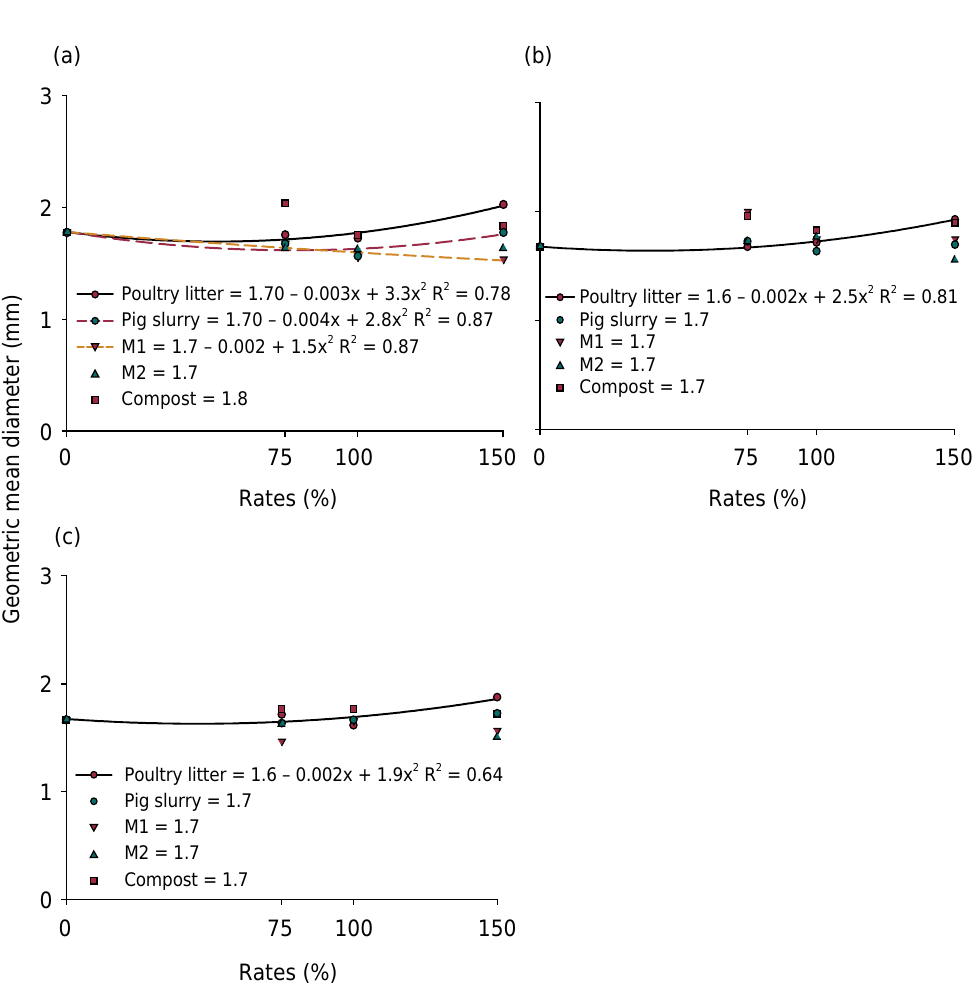
Figure 2. Geometric mean diameter (mm) of aggregates from a Rhodic Kandiudox, in the layers after seven years of different types and rates of organic and mineral fertilizers application. (a) 0.00-0.05 m soil layer; (b) 0.05-0.10 m soil layer; and (c) 0.10-0.20 m soil layer. M1: mineral fertilizer 1, equivalent to pig slurry; M2: mineral fertilizer 2, equivalent to poultry